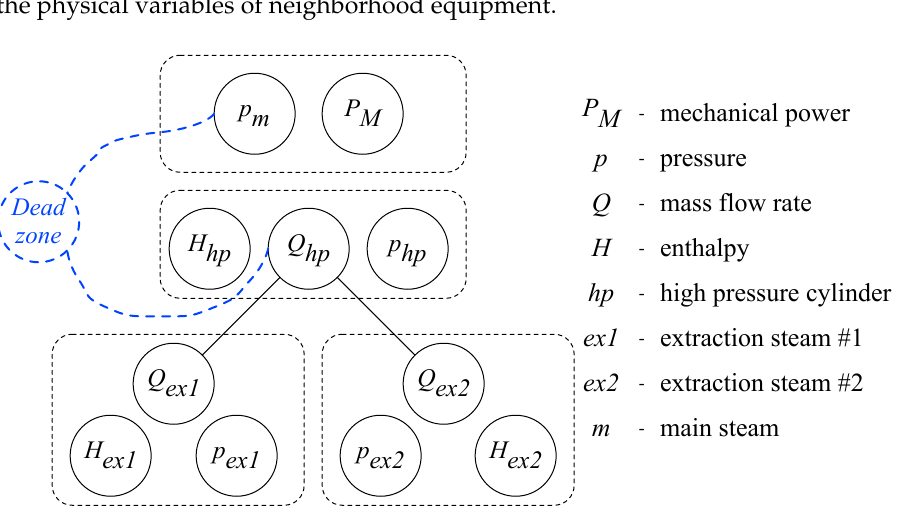
Figure 2. Diagram of an uncompleted graph for control valve dead zone